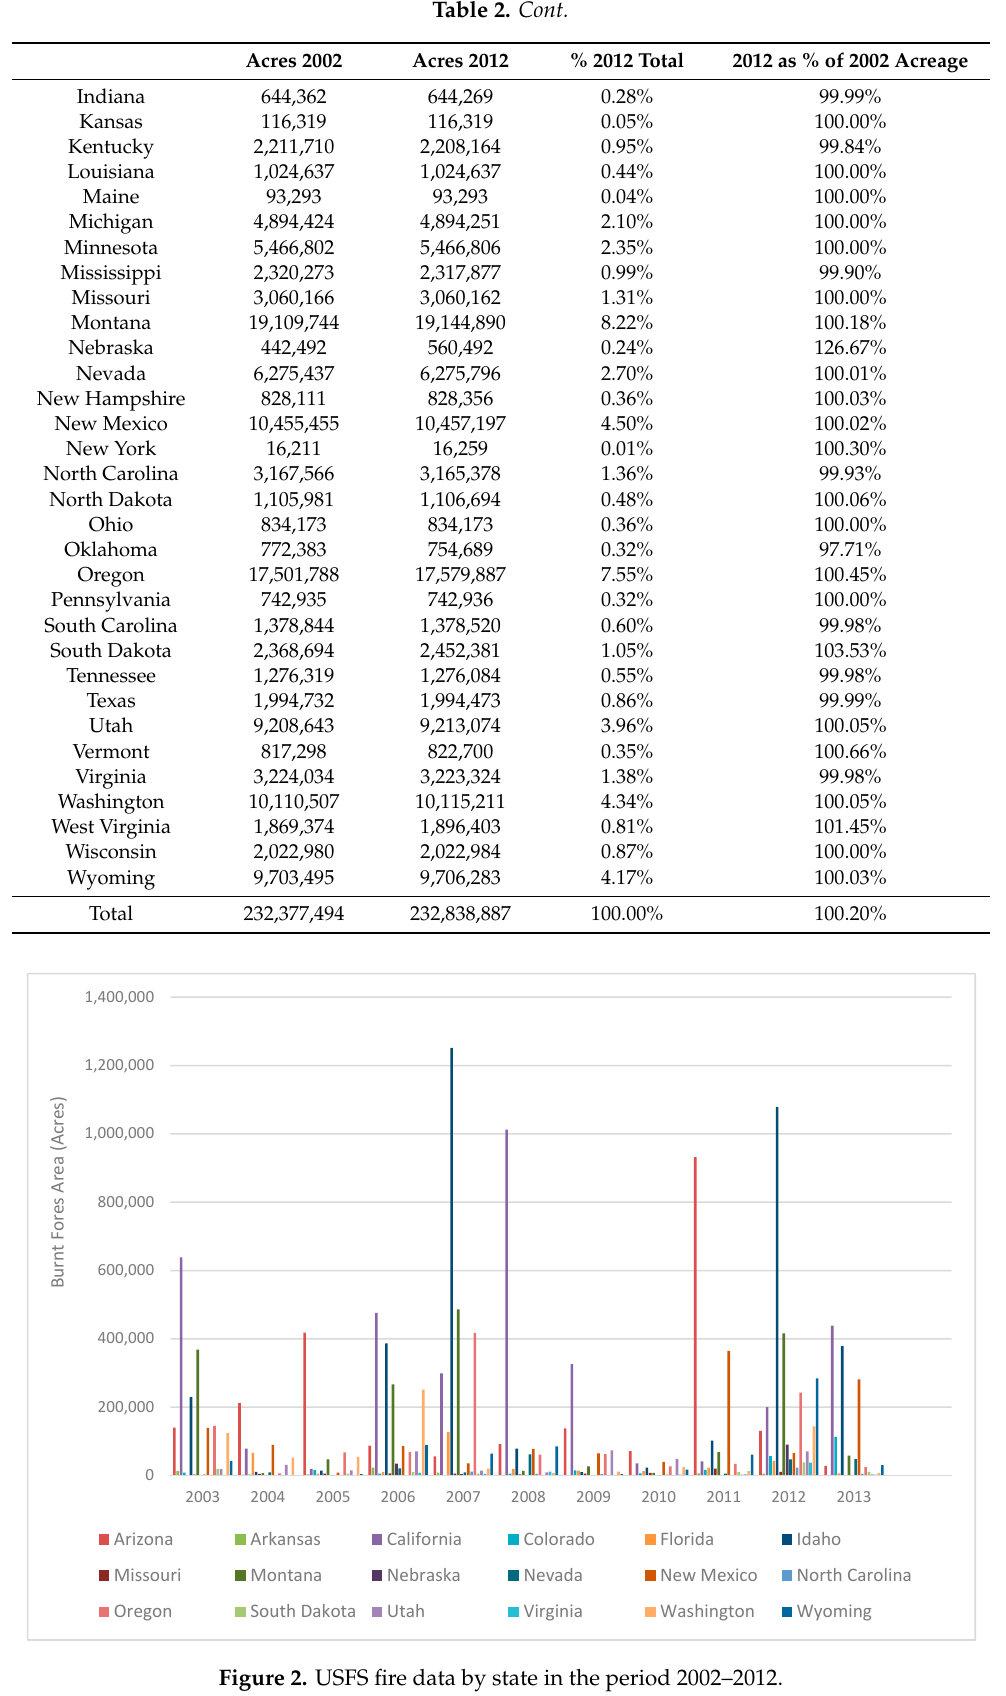
Figure 2. USFS fire data by state in the period 2002–2012.